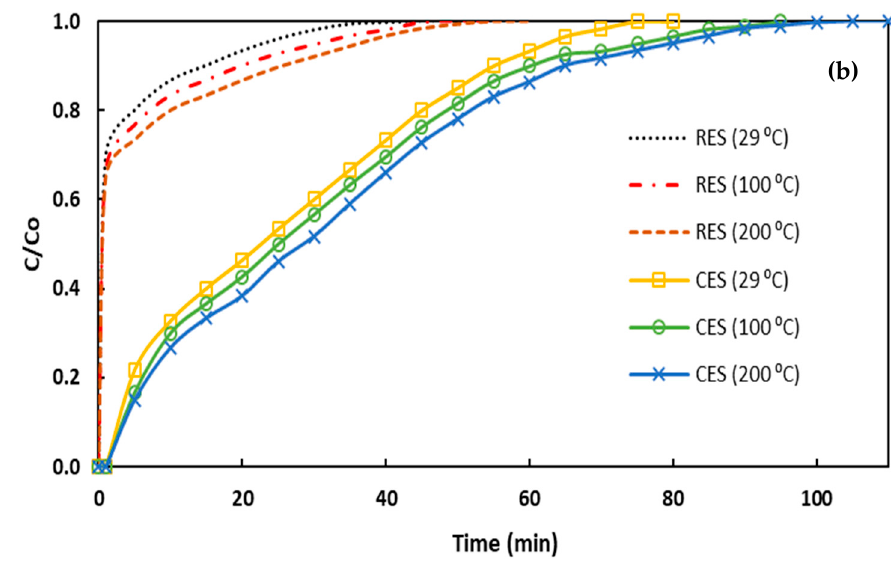
Figure 7. Breakthrough curves of ( a ) SO 2 and ( b ) H 2 S at different reaction temperature.